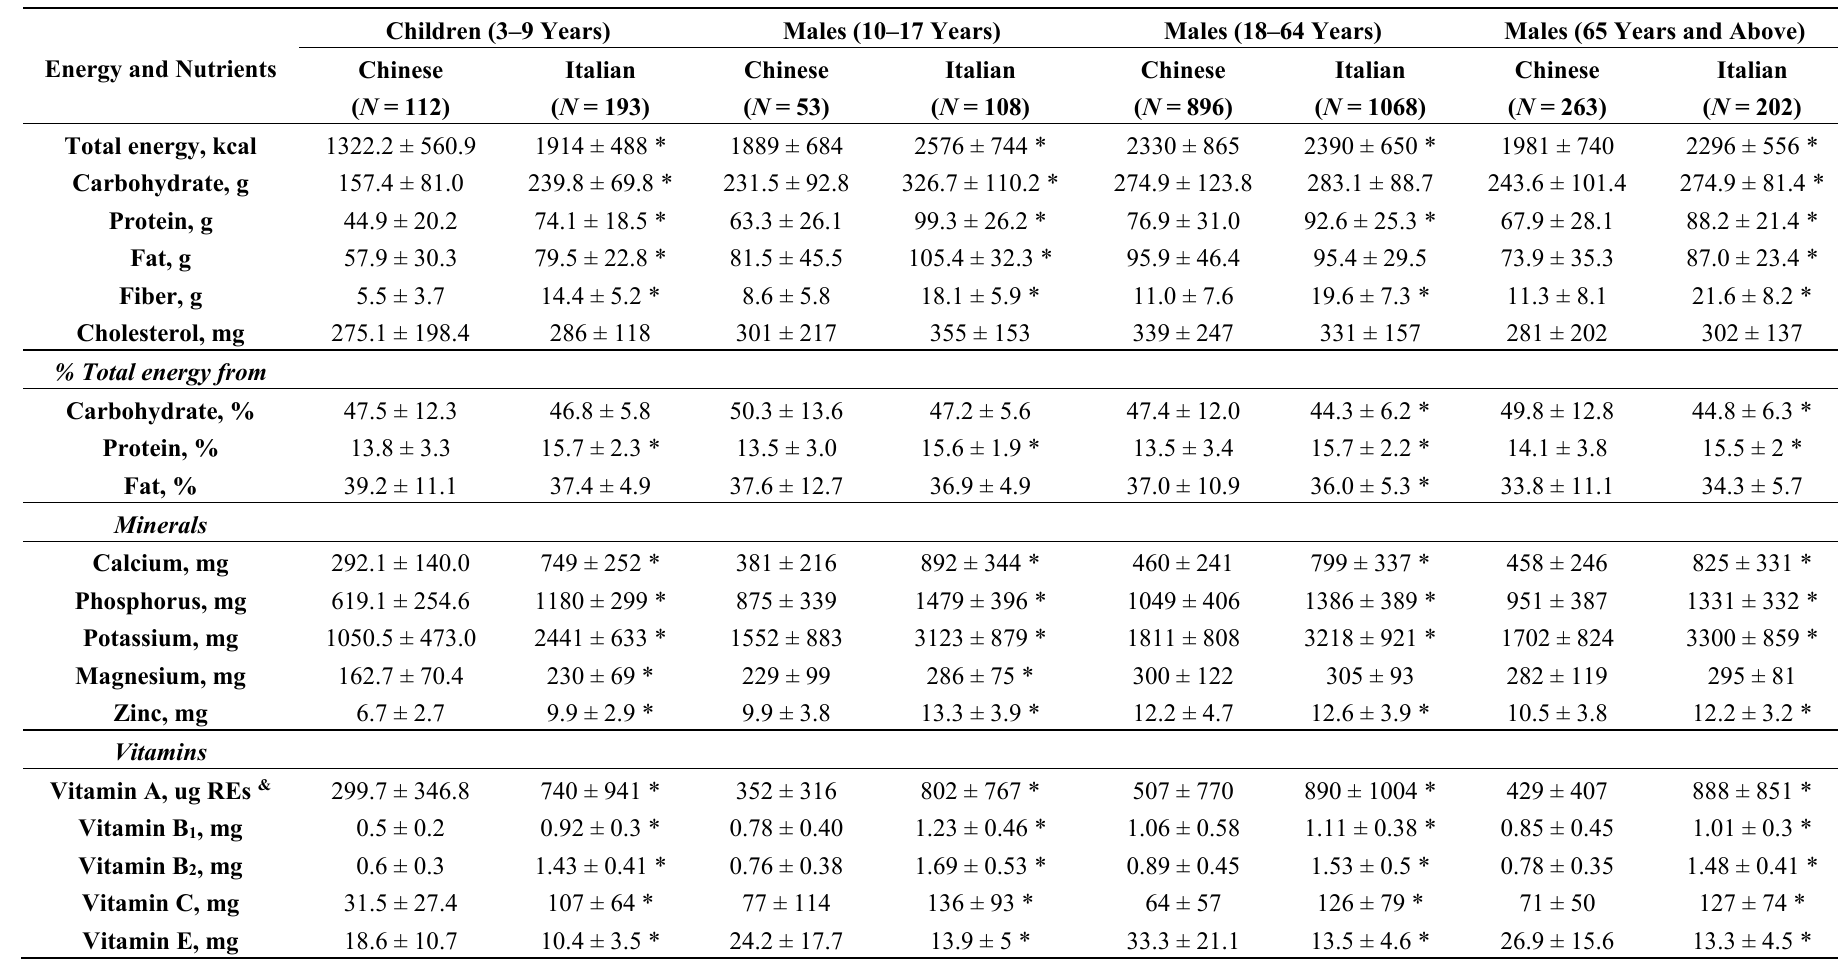
Table 5. Comparison of daily intake of energy and nutrients # by age in children ^ and males in the Chinese and Italian groups. Energy and